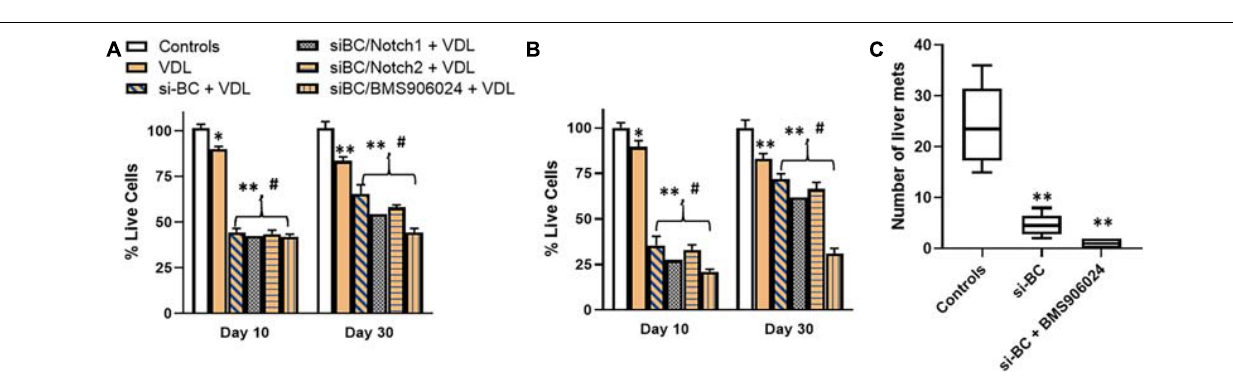
FIGURE 5 | Cells derived from relapsed patients and effect of Notch silencing. β -catenin-high cells derived from (A) patient 1 and (B) patient 2 were subjected to VDL treatment, as described in section “Materials and Methods,” in the presence and absence of si-RNAs specific for β -catenin (BC), Notch1, Notch2 or 100 nM pan-Notch inhibitor, BMS906024. Live cells were estimated at days 10 and 30, by trypan blue exclusion method. (C) Cells (50,000) from patient 2, ± si- β -catenin or si- β -catenin + BMS906024, as indicated, were also injected into the tail veins of mice ( n = 6, each), intra-venously. Mice were euthanized after 7 weeks and hepatic metastases evaluated. Bar graphs represent number of metastatic nodules counted. ∗ p < 0.05 and ∗∗ p < 0.01, compared to control, # p < 0.01, compared to